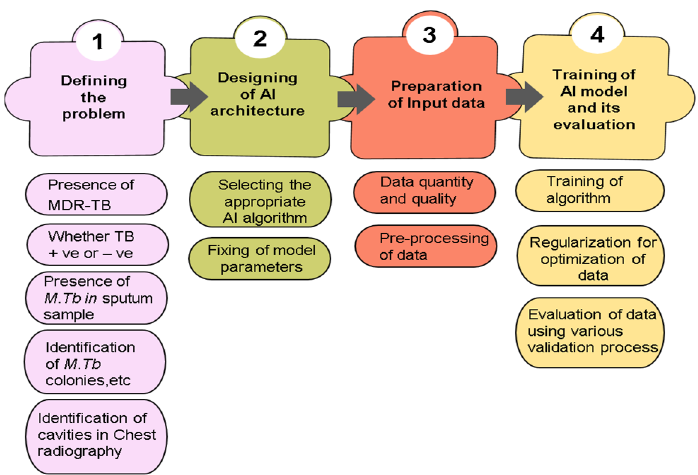
Figure 2. Steps involved in the construction of AI model for TB